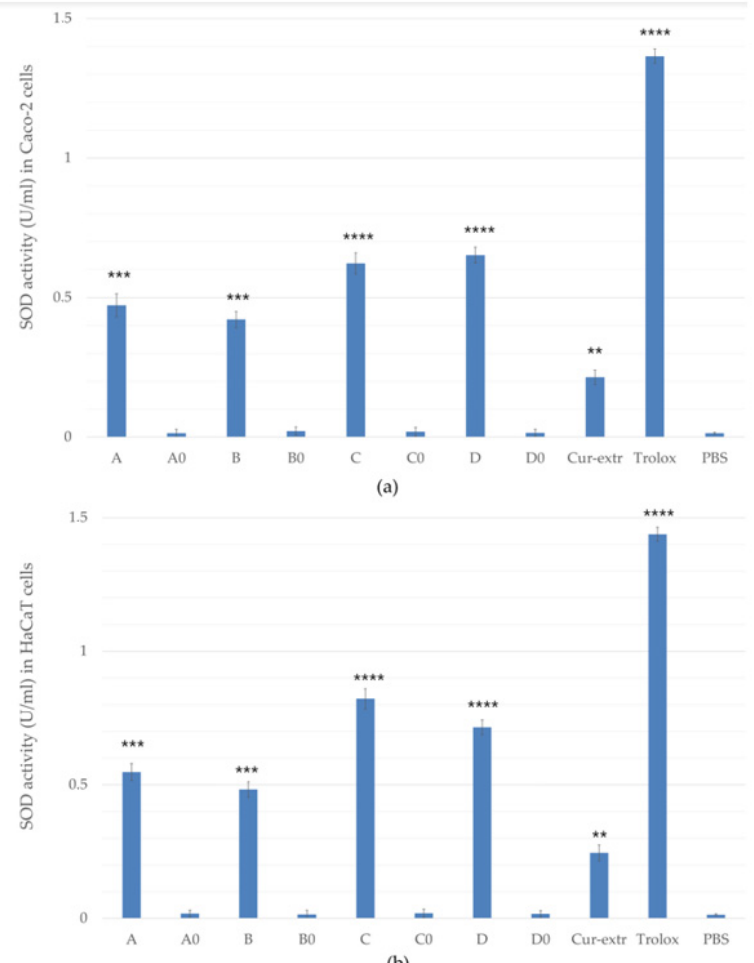
Figure 7. Effects of pretreatment with compositions on superoxide dismutase (SOD) enzyme activity in Caco-2 ( a ) and HaCaT cells ( b ). Cells treated with PBS were used as negative control. As positive control, Trolox (10.0 µM) dissolved in PBS was used. Data are expressed as the mean ± S.D. and n = 12. Ordinary one-way ANOVA with Dunnett’s multiple comparison test was performed to compare the different formulations with PBS. The **, ***, and **** indicate statistically significant differences at p < 0.01, p < 0.001, and p < 0.0001.